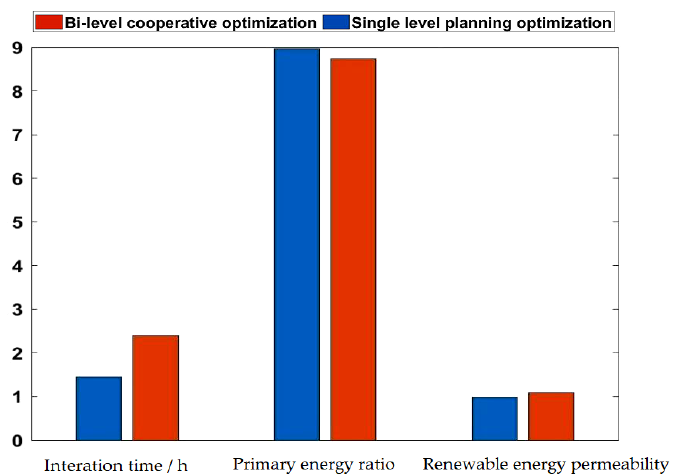
Figure 8. Comparison of iteration time and energy efficiency.